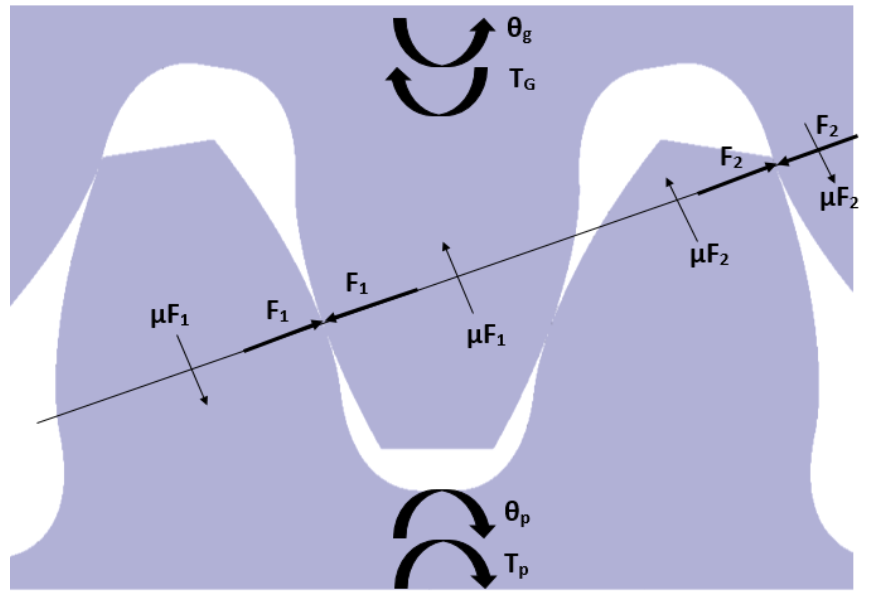
Figure 6. The free-body diagram of 2-DOF gear system.